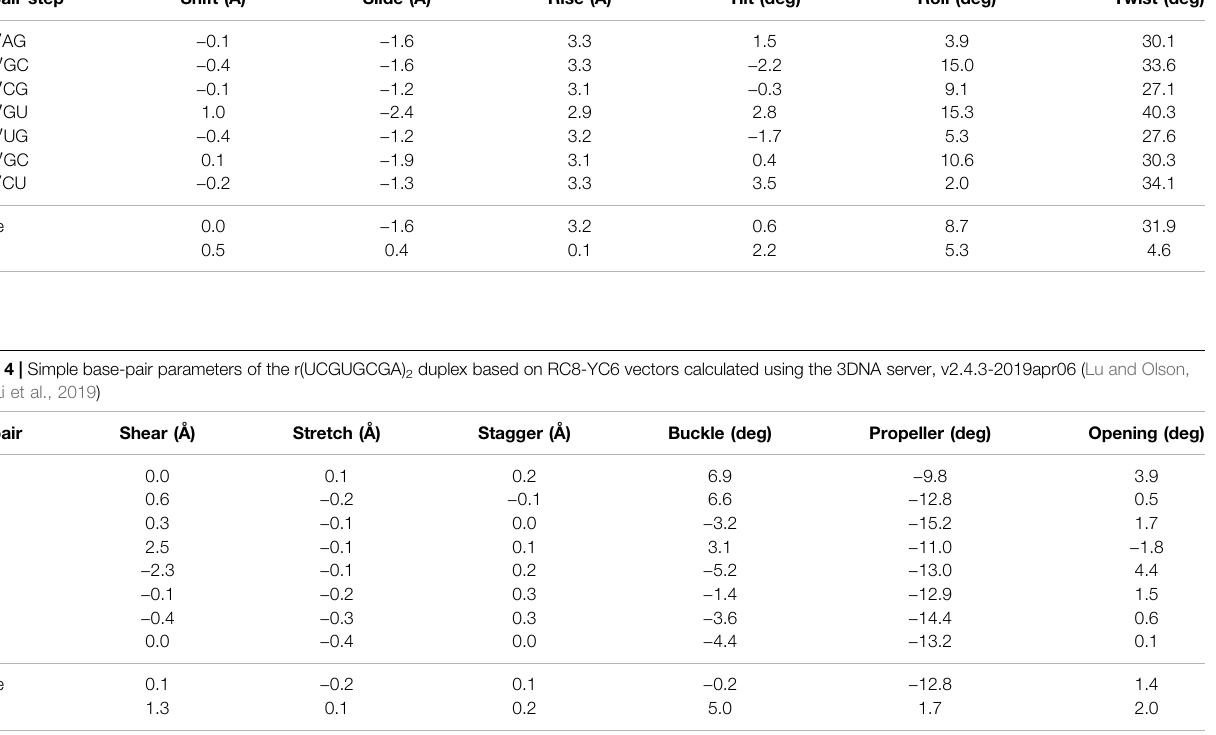
Figure 7 ). The compensatory effect of the under- and overtwisting of the 5 ′ UG/3 ′ GU tandem and associated base pairs allowed the RNA duplex to maintain an average twist of ∼ 32 ° , which was close to the value for a typical A-RNA helix. A